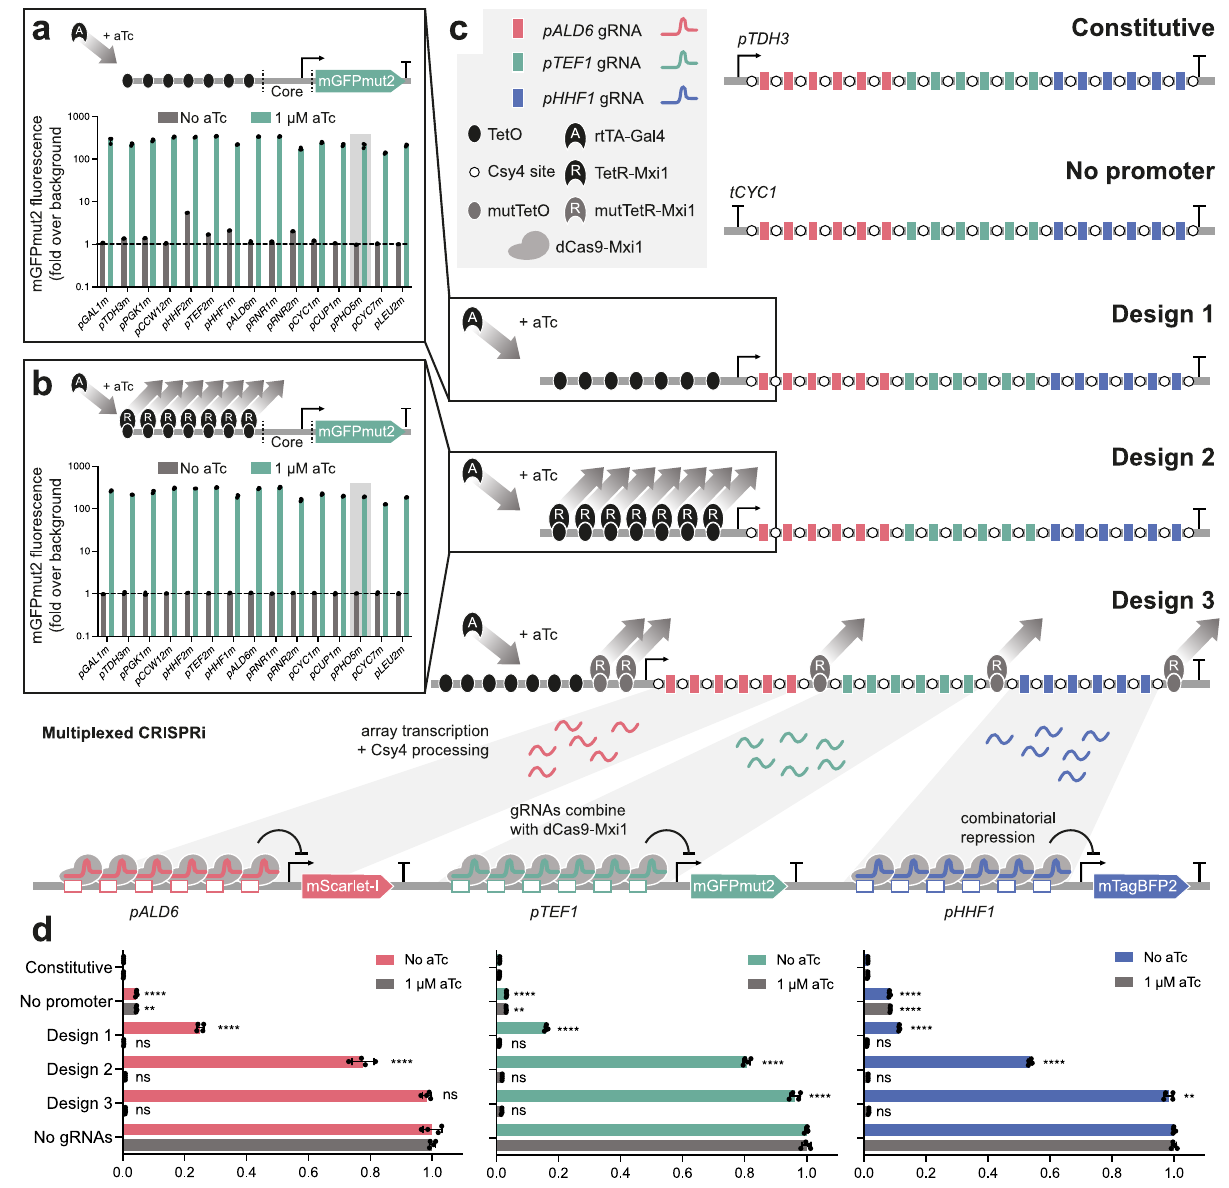
Fig. 1 | Development ofinduciblegRNAarrays.a Development of a low-leak, aTc induciblepromoter.rtTA-Gal4targeting7xTetOsitesupstreamofacorepromoter library driving the expression of mGFPmut2. Addition of 1 µ M aTc recruits rtTA- Gal4 to the promoter, upregulating the expression of mGFPmut2. The PHO5 minimalcorepromoter( pPHO5m )exhibited the lowest levelof basalactivity inthe absence of inducer, and was used in the initial inducible gRNA array, Design 1. b Development of a leak-free, aTc inducible promoter. The aTc-repressible TetR protein fused to the strong transcriptional repressor Mxi1 (TetR-Mxi1) was intro- ducedalongsidertTA-Gal4tobindTetOsitesintheabsenceofinducerandrepress low levels of basal transcription in the off state 41 , reducing all promoters to unde- tectable levels of mGFPmut2 fl uorescence in the absence of inducer. The low-leak 7xTetO- PHO5m promoter was again chosen to build the second iteration of the